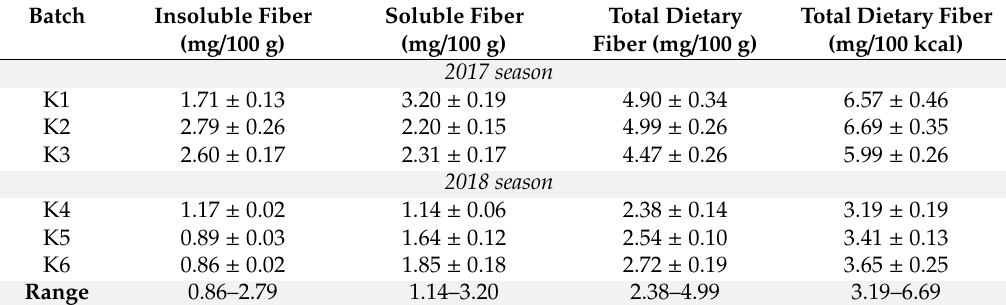
Table 3. Insoluble, soluble and total dietary fiber values (mg / 100g fw) of deastringed persimmon fruits (‘Rojo Brillante’ variety) analysed in the 2017 and 2018 seasons. Results expressed as mean ± standard deviation ( n -1), n =